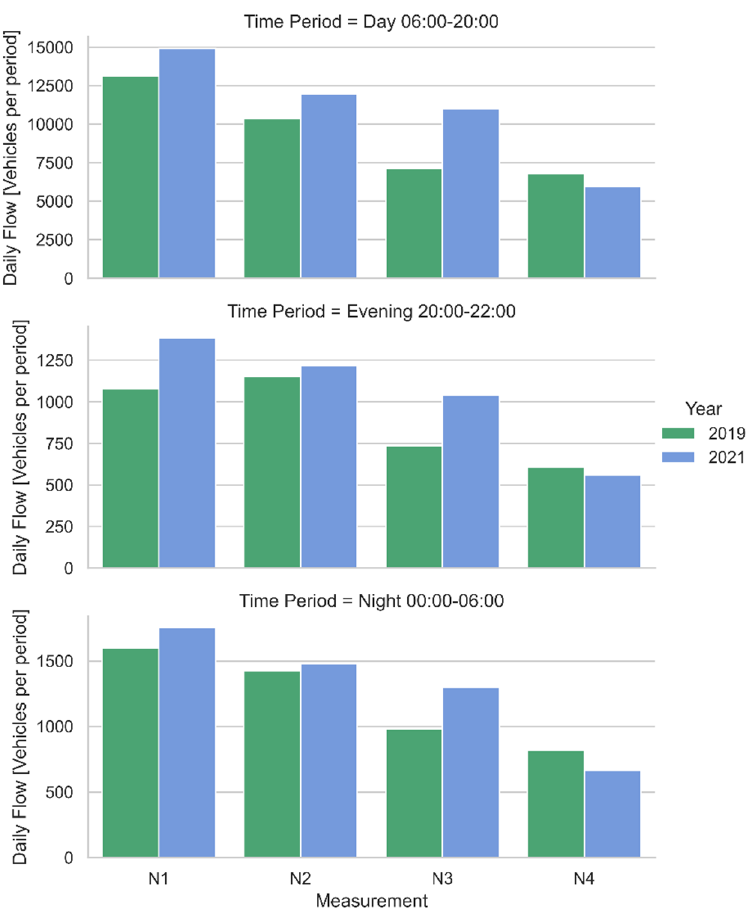
Figure 11. Overall traffic flow measured in positions N1–N4 for both years 2019 and 2021 divided into period of the day.